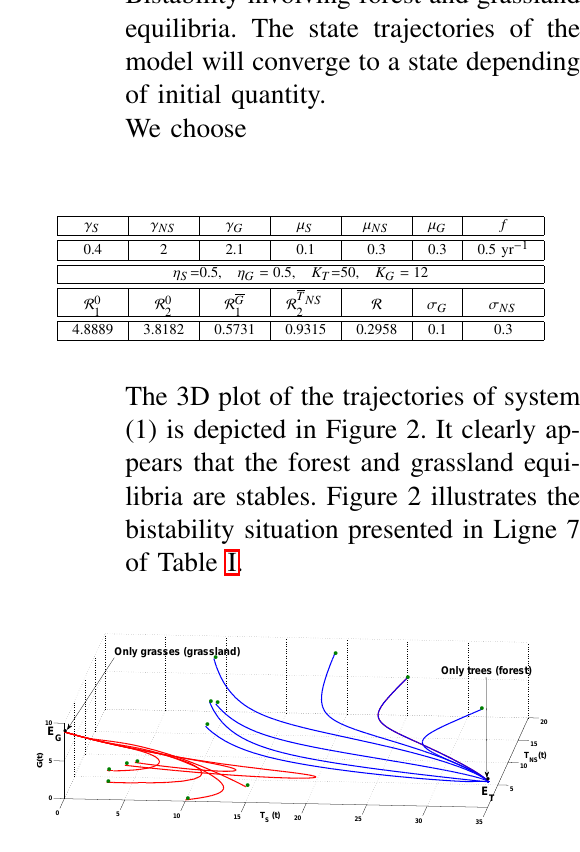
Fig. 2. 3D plot of the trajectories of system (1) showing that the forest ( E T ) and grassland ( E G ) equilibria are stable. The green bullets represent di ff erent initial